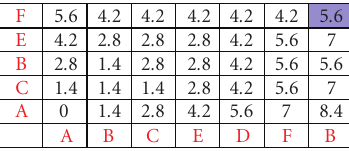
Figure 2: Derivation of dynamic time warping distance between X and Y